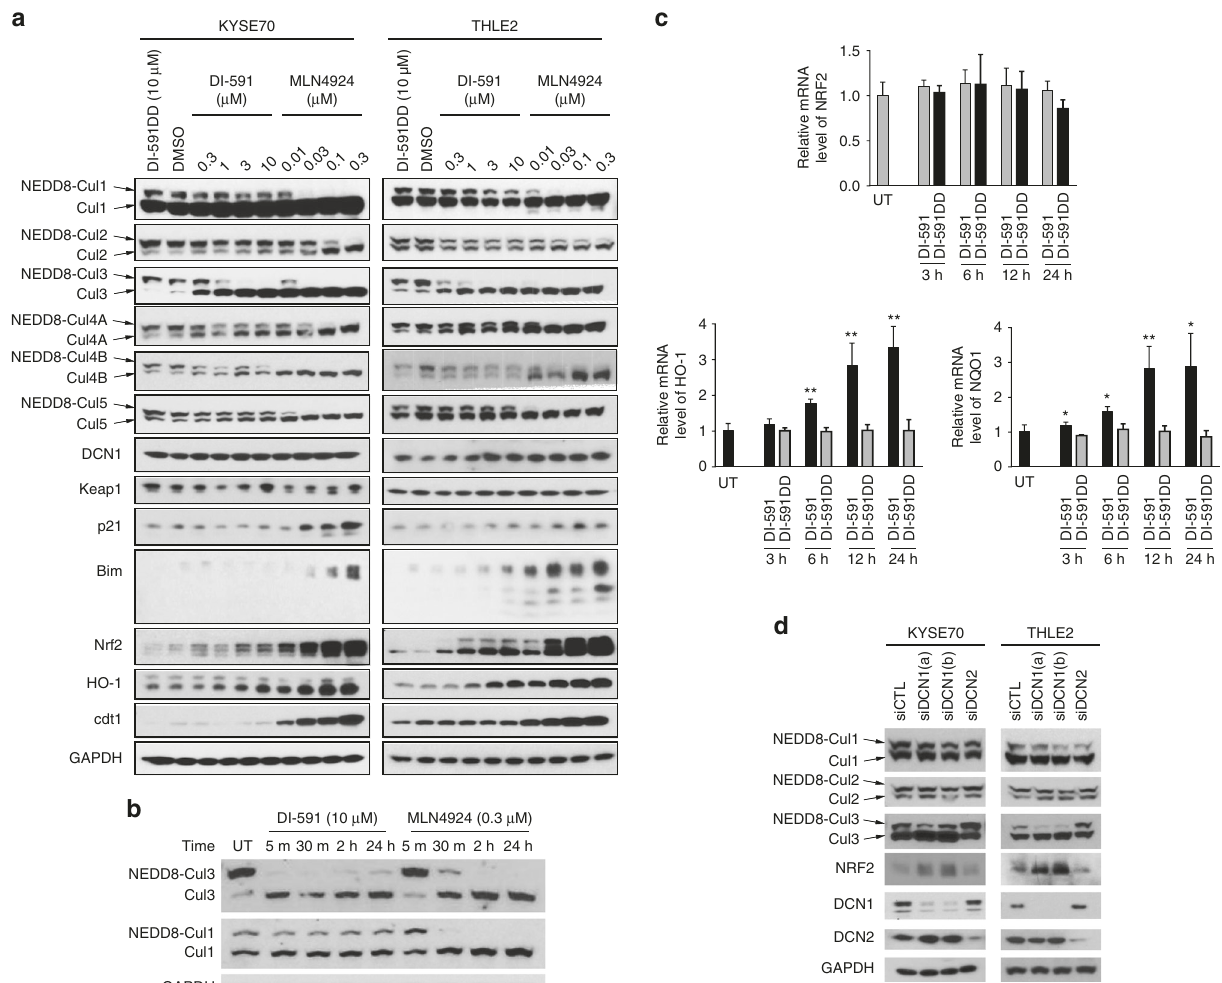
Fig. 5 DI-591 selectively and rapidly inhibits neddylation of cullin 3. a Western blotting of neddylated and un-neddylated cullin family members and several representative well-known substrates of cullin CRLs in KYSE70 esophageal cancer cells and THLE2 immortalized liver cells. Cells were treated with DCN1 inhibitor DI-591 or NAE E1 inhibitor MLN4924 at indicated concentrations, or DI-591DD at 10 µ M for 24 h. Protein levels of neddylated and un-neddylated cullin family members and several known substrates of cullin CRLs were examined by western blotting analysis. GAPDH was used as a loading control. b Inhibition kinetics of neddylation of cullin 1 and 3 by DI-591 and MLN4924 in THLE2 liver cells. Cells were treated with DI-591 at 10 µ M or MLN4924 at 0.3 µ M at indicated time points. Protein levels of neddylated and un-neddylated cullin 1 and 3 were examined by western blotting analysis. GAPDH was used as a loading control. c qRT-PCR analysis of mRNA levels of NRF2 and NRF2-reguated genes in THLE2 cells. Cells were treated with DI-591 at 10 µ M, DI-591DD at 10 µ M or DMSO for indicated time points. The relative mRNA levels of NRF2, NQO1 and HO-1 were examined by quantitative real-time RT-PCR assay. GAPDH was used as an internal control. The averages and standard deviations for each column were calculated from total nine samples obtained from three independent experiments (each experiment with triplicates). P -value from t-test: * P < 0.05, ** P < 0.01. d Effect of siRNAs-mediated DCN1 knockdown on neddylation of cullin 1, 2, and 3. KYSE70 and THLE2 cells were transfected with small interfering RNAs against DCN1 using two different constructs or DCN2 or non-targeting siRNA oligo control (siCTL) for 48 h. The effectiveness of siRNA knockdown on DCN1 or DCN2 and the effect on the levels of neddylated- and un-neddylated cullin 1, 2, 3, and NRF2 proteins were examined by western blotting analysis. GAPDH was used as a loading